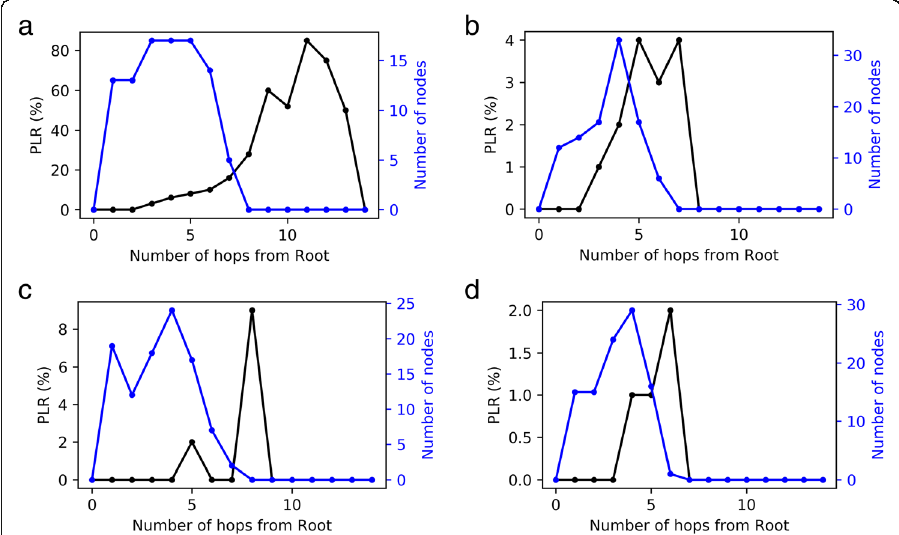
Fig. 9 PLR at different sending intervals. a One packet per node every 10 s. b One packet per node every 20 s. c One packet per node every 60 s. d One packet per node every 120 s. This result allows us to